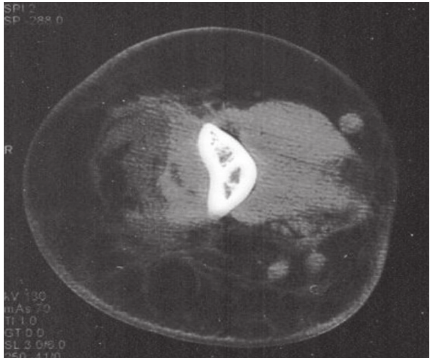
Figure 3: CT scan of left arm: fluidic collection with heterogeneous rearrangement of the fatty tissue with septa thickened and presence of muscular necrosis.